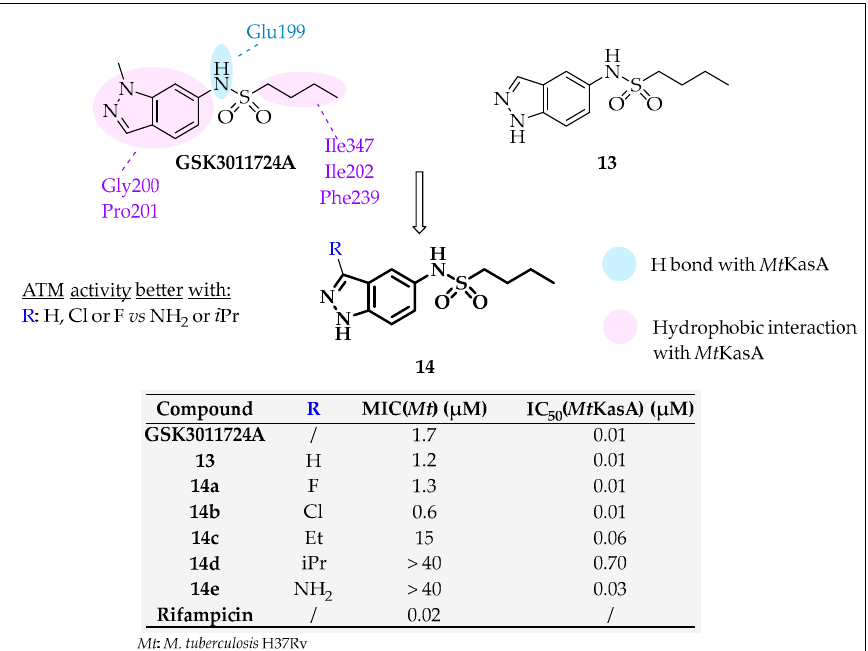
Figure 13. Structures, SAR and representation of main interactions with Mt KasA of GSK3011724A and its derivatives 13–14 and in vitro activities of lead compounds [83–85]. and its derivatives 13–14 and in vitro activities of lead compounds